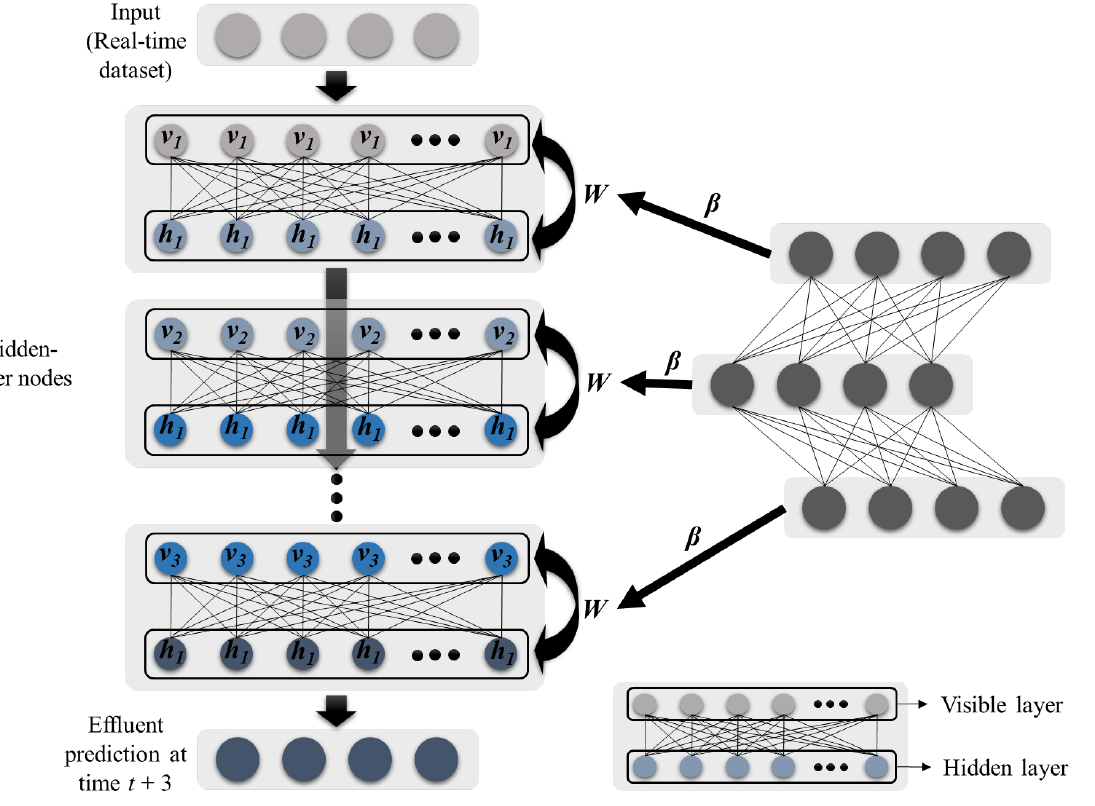
Figure 4. Architecture of MLP modeling for predicting future WWTP effluent water